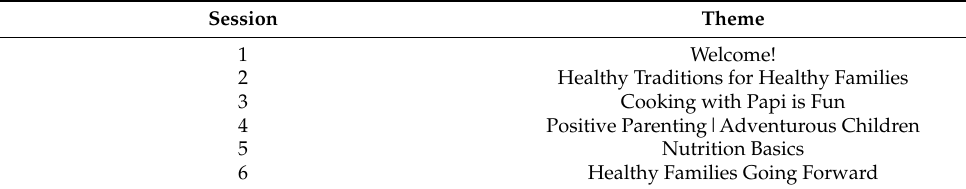
Table 1. Weekly themes by